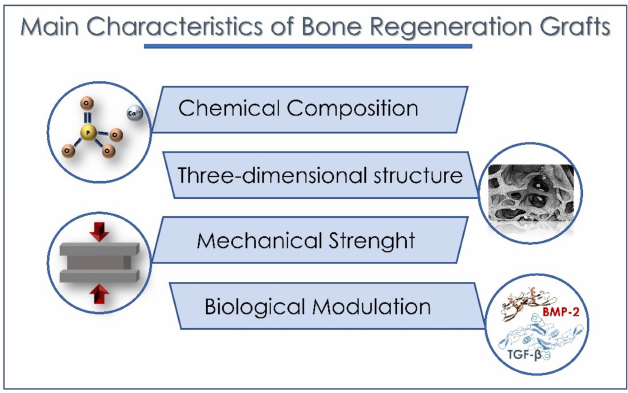
Figure 2. Synthesis of the biomaterials for bone